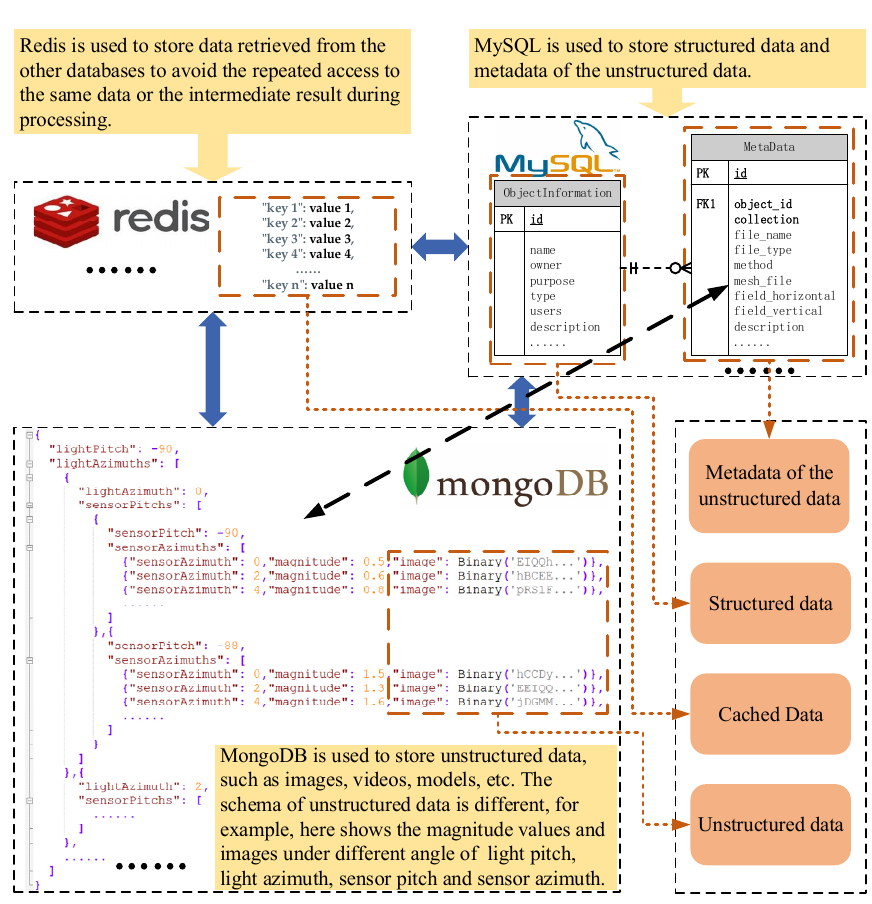
Figure 4. Hybrid SQL/NoSQL logical model and cases. Different databases store different data and collaborate with each other to provide a unified data service.